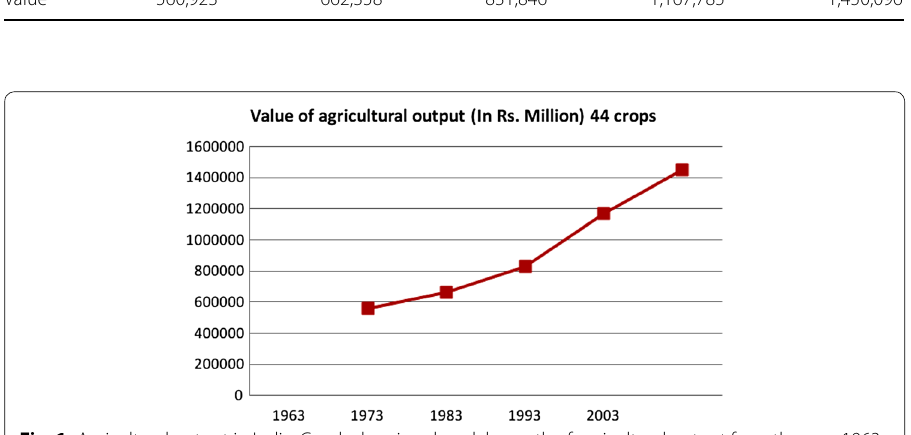
Fig. 1 Agricultural output in India. Graph showing decadal growth of agricultural output from the year 1963 to 2003, of crops in